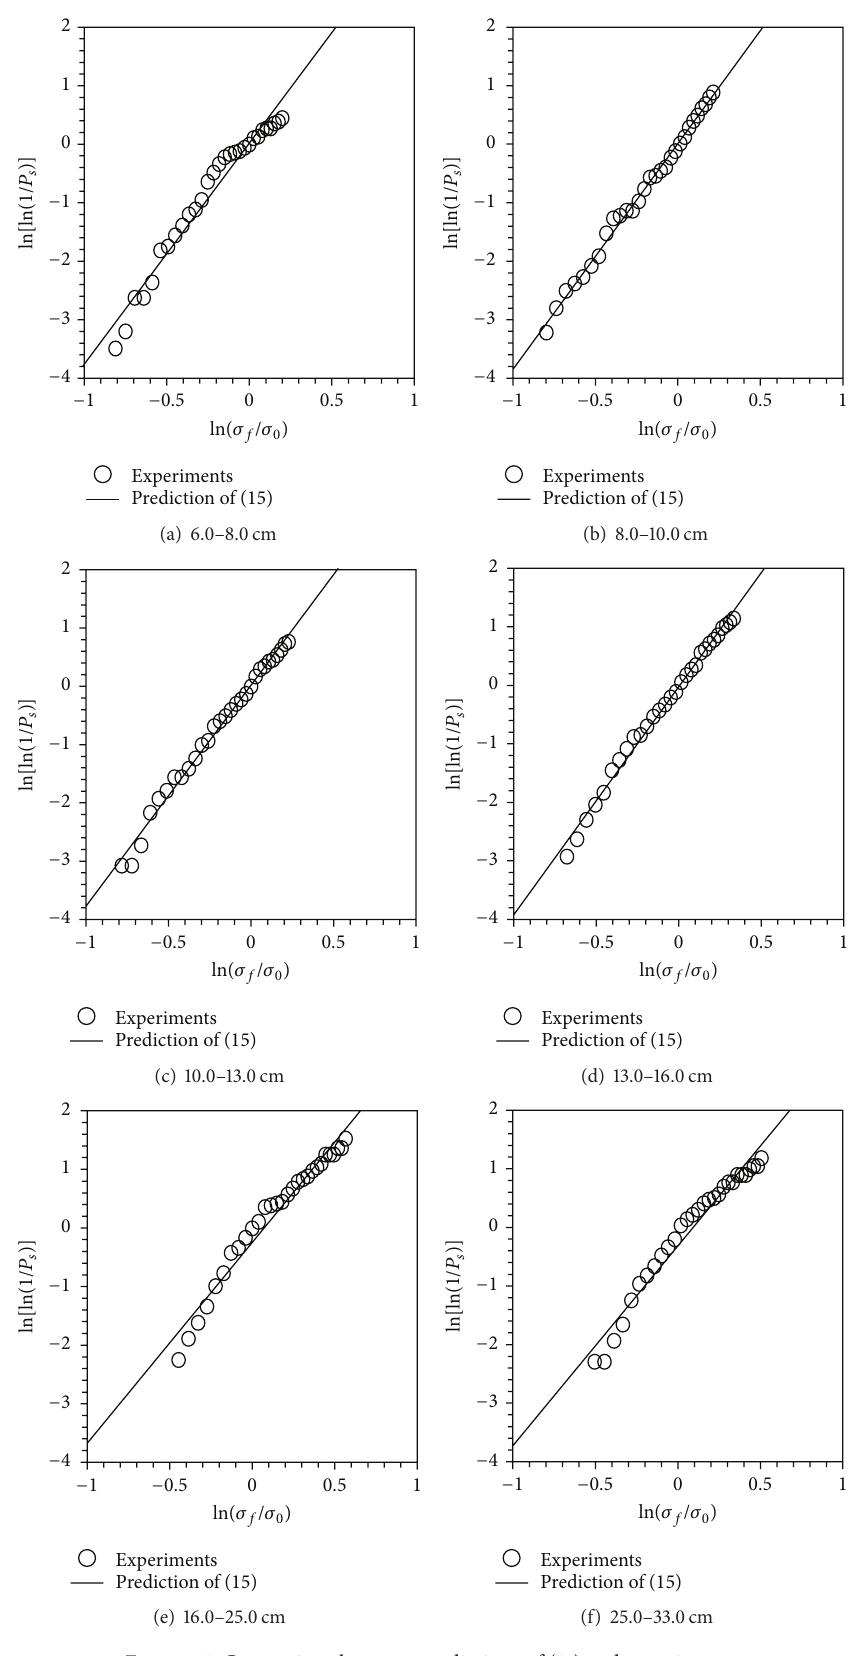
Figure 11: Comparison between predictions of (15) and